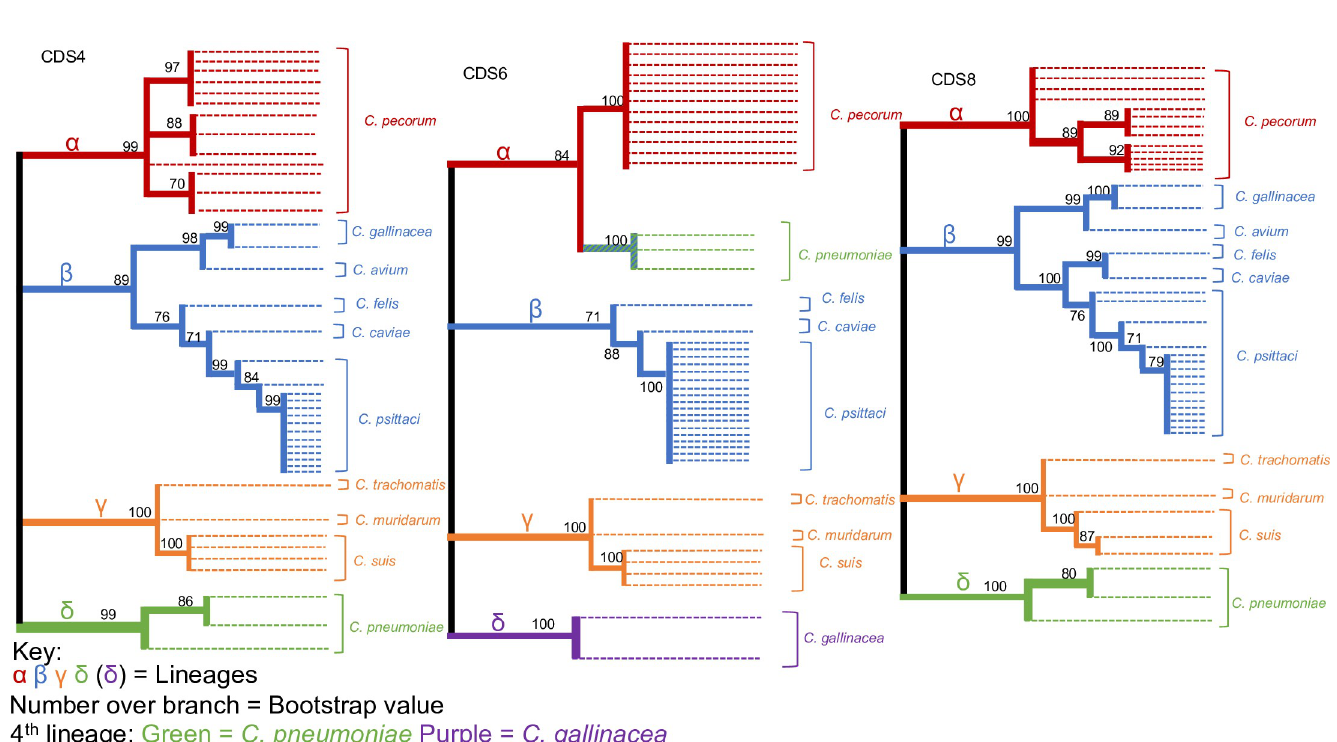
Fig 5. The Maximum Likelihood estimate for gene group B with the following 3 coding sequences being present; CDS4, CDS6, and CDS8.